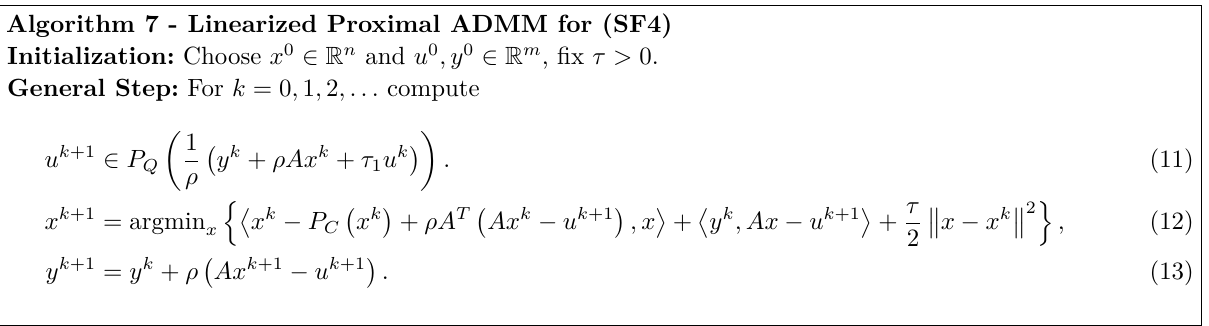
Algorithm 7 - Linearized Proximal ADMM for